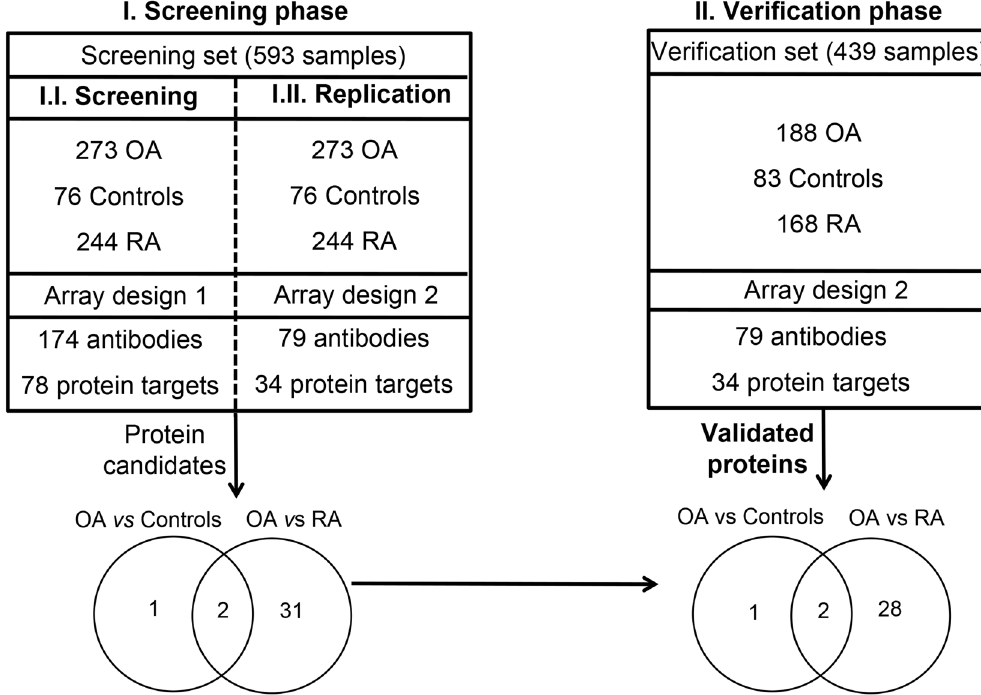
Figure 1. Schematic overview of the study. A screening phase was performed using a set of 593 serum samples and a protein array composed of 174 antibodies targeting 78 different proteins (Array 1, Phase I.I.). The levels of three proteins were found significantly (P < 0.05) different between osteoarthritis (OA) patients and control individuals, and 33 proteins differed between OA and rheumatoid arthritis (RA). A more focused array (Array 2) was then built targeting these 34 different proteins with 79 antibodies, and the results were replicated in the same sample set (Phase I.II.). Finally, a verification phase (II) was carried out using this second array on an independent set of 439 serum samples. In this phase, the three biomarker candidates separating OA and controls were verified, as well as 30 of the 33 proteins that were found with altered levels between OA and RA